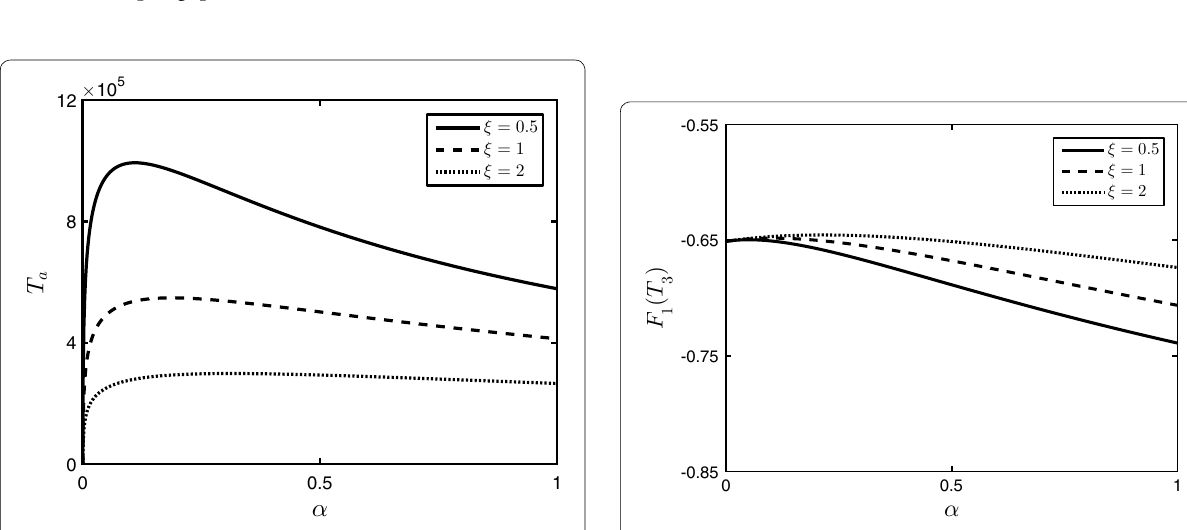
Fig. 3 Tangential force on the asperity at the end of afterslip. The tan- gential force (83) is plotted as a function of the coupling parameter α for different values of the parameter ξ . Other parameters are ǫ and γ =